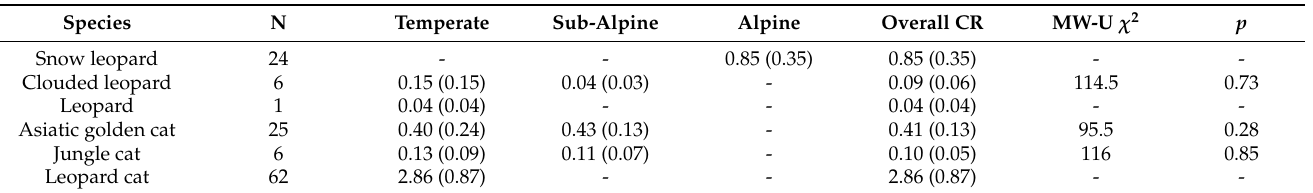
Table 1. Photo-capture rate ( ± standard error) of felids in different habitats of the Prek catchment with Mann–Whitney U statistics ( p denotes statistical significance).